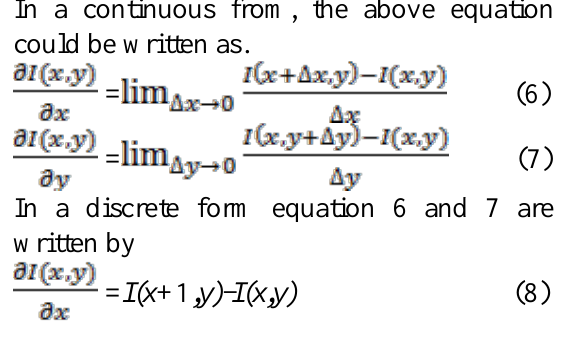
Fig. 5: Cross section through the comet passing the center of the nucleus showing the transition points that local the boundaries of four